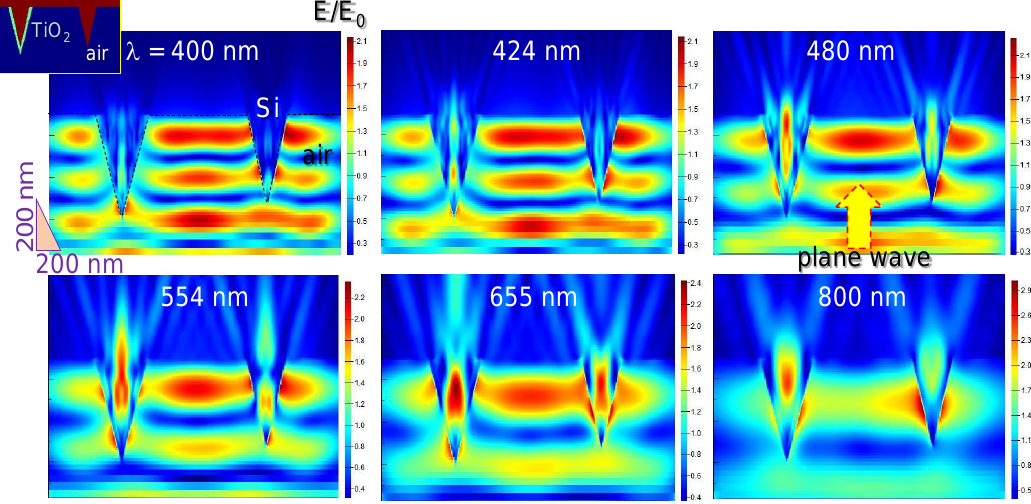
Figure A2. Finite differences time domain (FDTD) simulations (Lumerical) of light intensity distribution on b-Si pyramids with 10 nm TiO 2 coating and without at different wavelengths λ . The inset shows the refractive index cross section where TiO 2 is modelled by n = 2.5 for all the wavelengths while refractive index of Si was taken from the Lumerical data base with real and imaginary parts ˜ n ( λ ) = n ( λ ) + i κ ( λ ) . The E-field is polarised in the plane of incidence and E 0 =